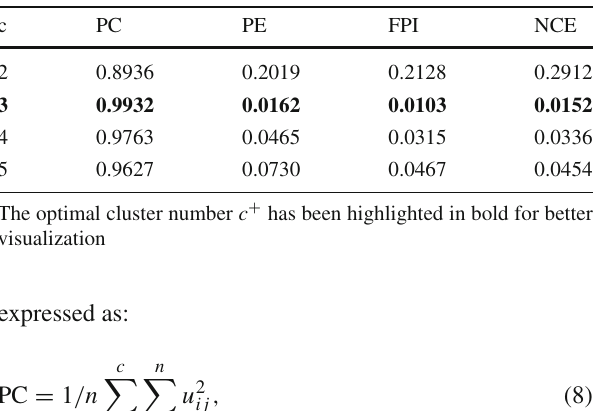
Table 2 Determination of optimum cluster